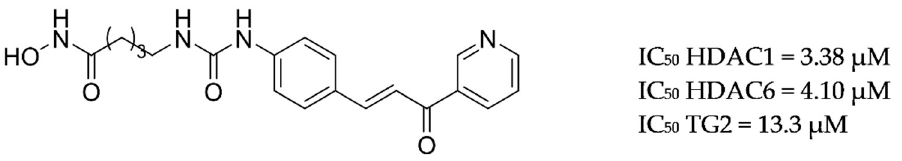
Figure 21. Dual TG2 and HDAC inhibitor from [186].